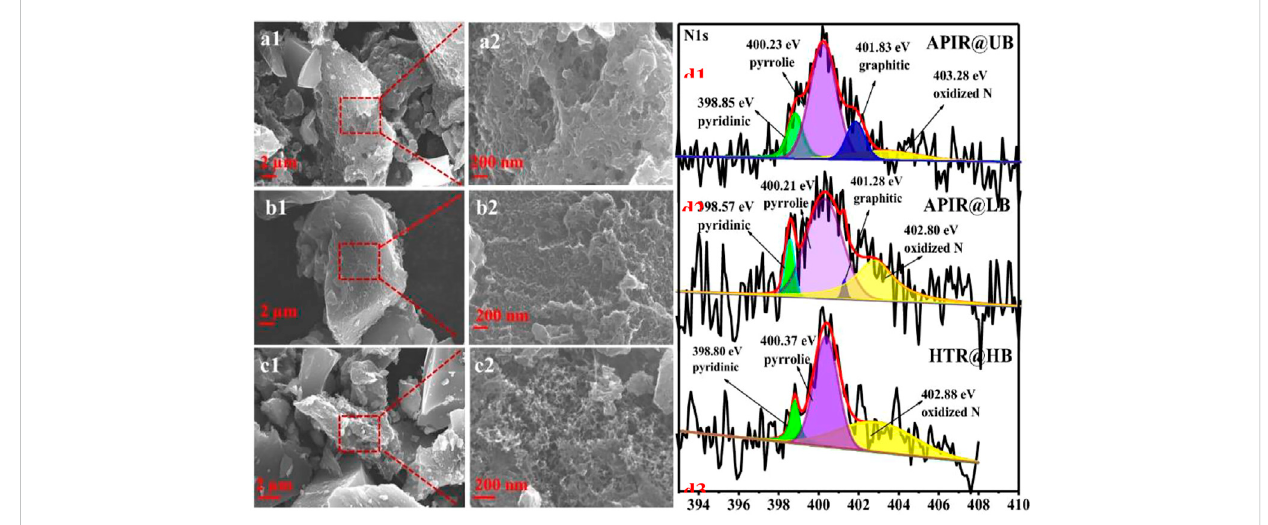
FIGURE 10 (a1, a2) and (b1, b2) SEM images of biochar pretreated by heating in an oven at 200 ° C, (c1, c2) SEM images of biochar pretreated by hydrothermal pre-carbonization at 200 ° C, and (d1-d3) comparison of N-functionalities between the derived carbons (Zhou et al., 2020).